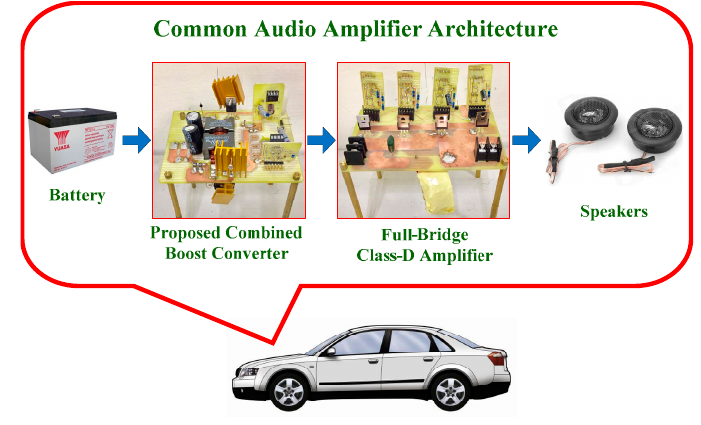
Figure 1. Illustration of the studied audio amplifier architecture.